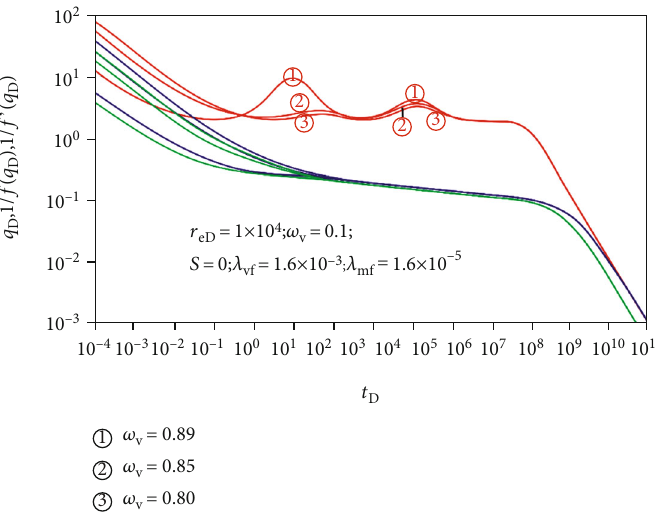
Figure 11: In fl uence of fl uid capacitance coe ffi cient of matrix, ω